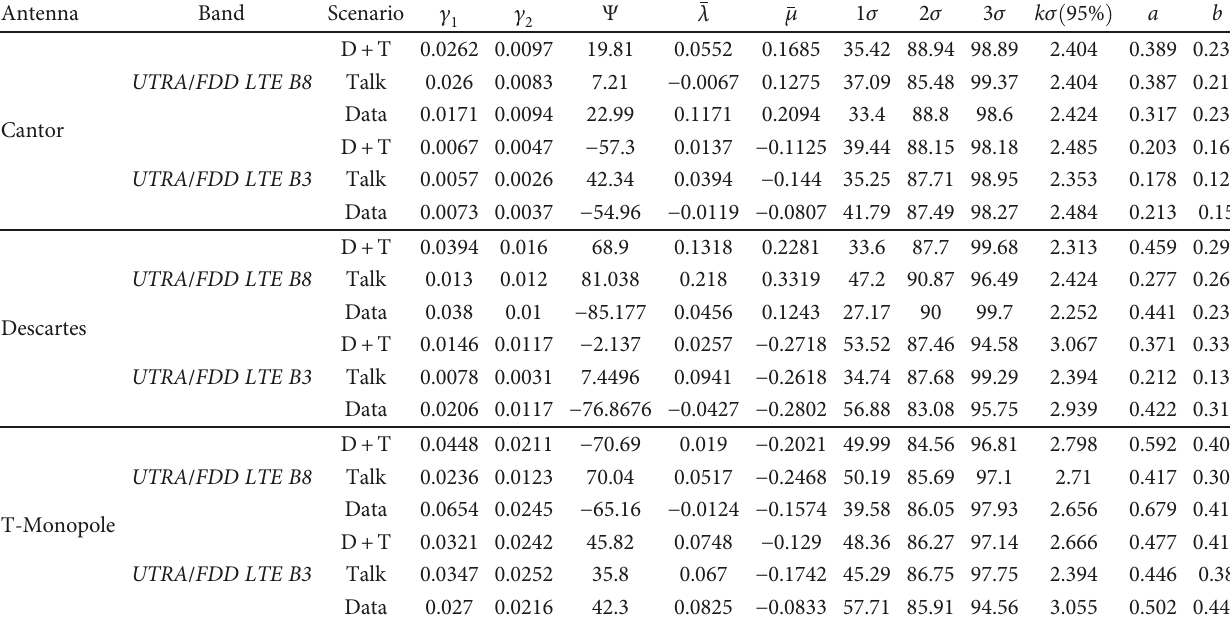
Figure 5: Impedance variability description with the ellipsoidal geometry and its fi ve parameters. Table 1: Uncertainty impedance ellipse parameters and con fi dence